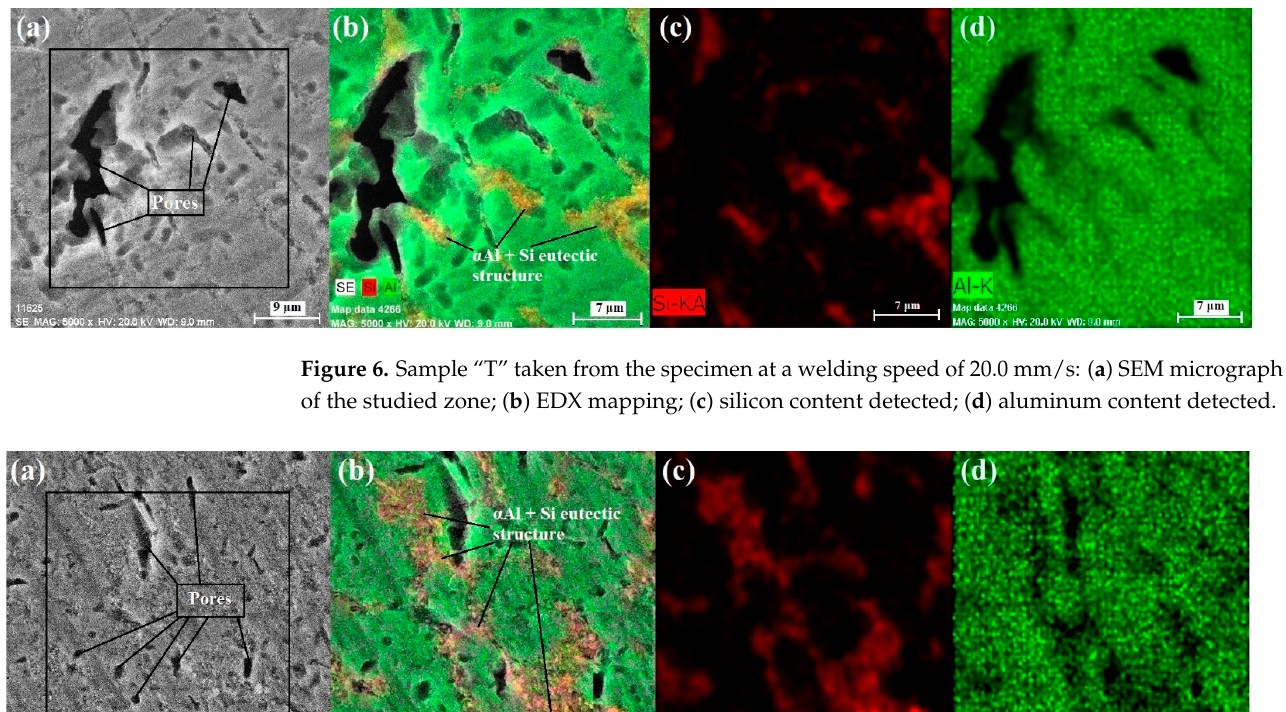
Figure 6. Sample “T” taken from the specimen at a welding speed of 20.0 mm/s: ( a ) SEM micrograph of the studied zone; ( b ) EDX mapping; ( c ) silicon content detected; ( d ) aluminum content detected. Figure 7. Sample “M2” taken from the specimen build at a welding speed of 20.0 mm/s: ( a ) SEM micrograph of the studied zone; ( b ) EDX mapping; ( c ) silicon content detected; ( d ) aluminum content detected.